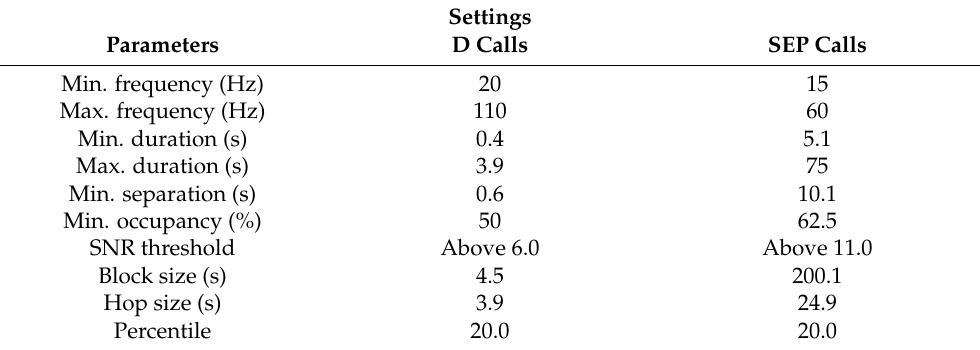
Table 2. Settings of the BLED detector (see Raven’s user manual [48] for descriptions of the param- eters) .